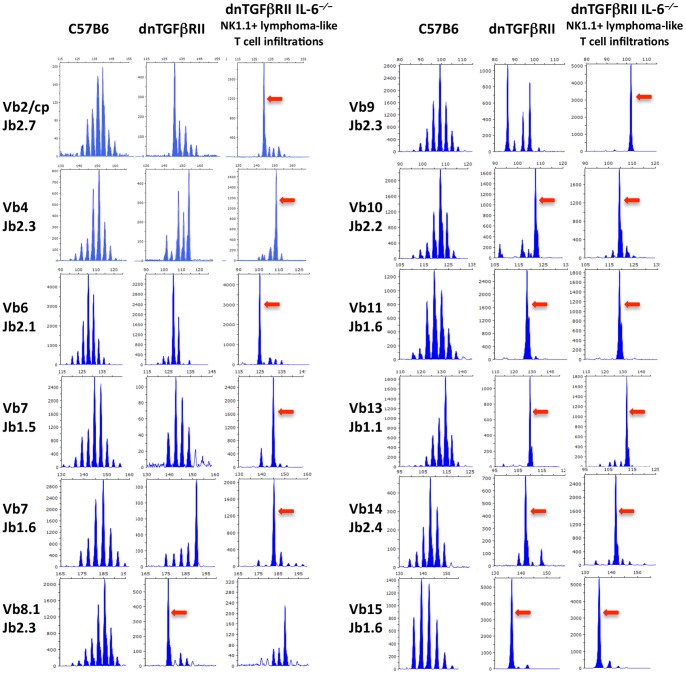
Comparison of CDR3 region of the TCR β family between dnTGFβRII and dnTGFβRII IL-6−/− mice.The arrows indicate clonal expansion of specific Vβ. C57B6 mice were used as negative control. With this technique, if there is no detectable T cell expansion within a Vβ spectrum, a Gaussian distribution of CDR3 lengths is observed. In contrast, clonal expansions are observed as a perturbation of this Gaussian distribution.